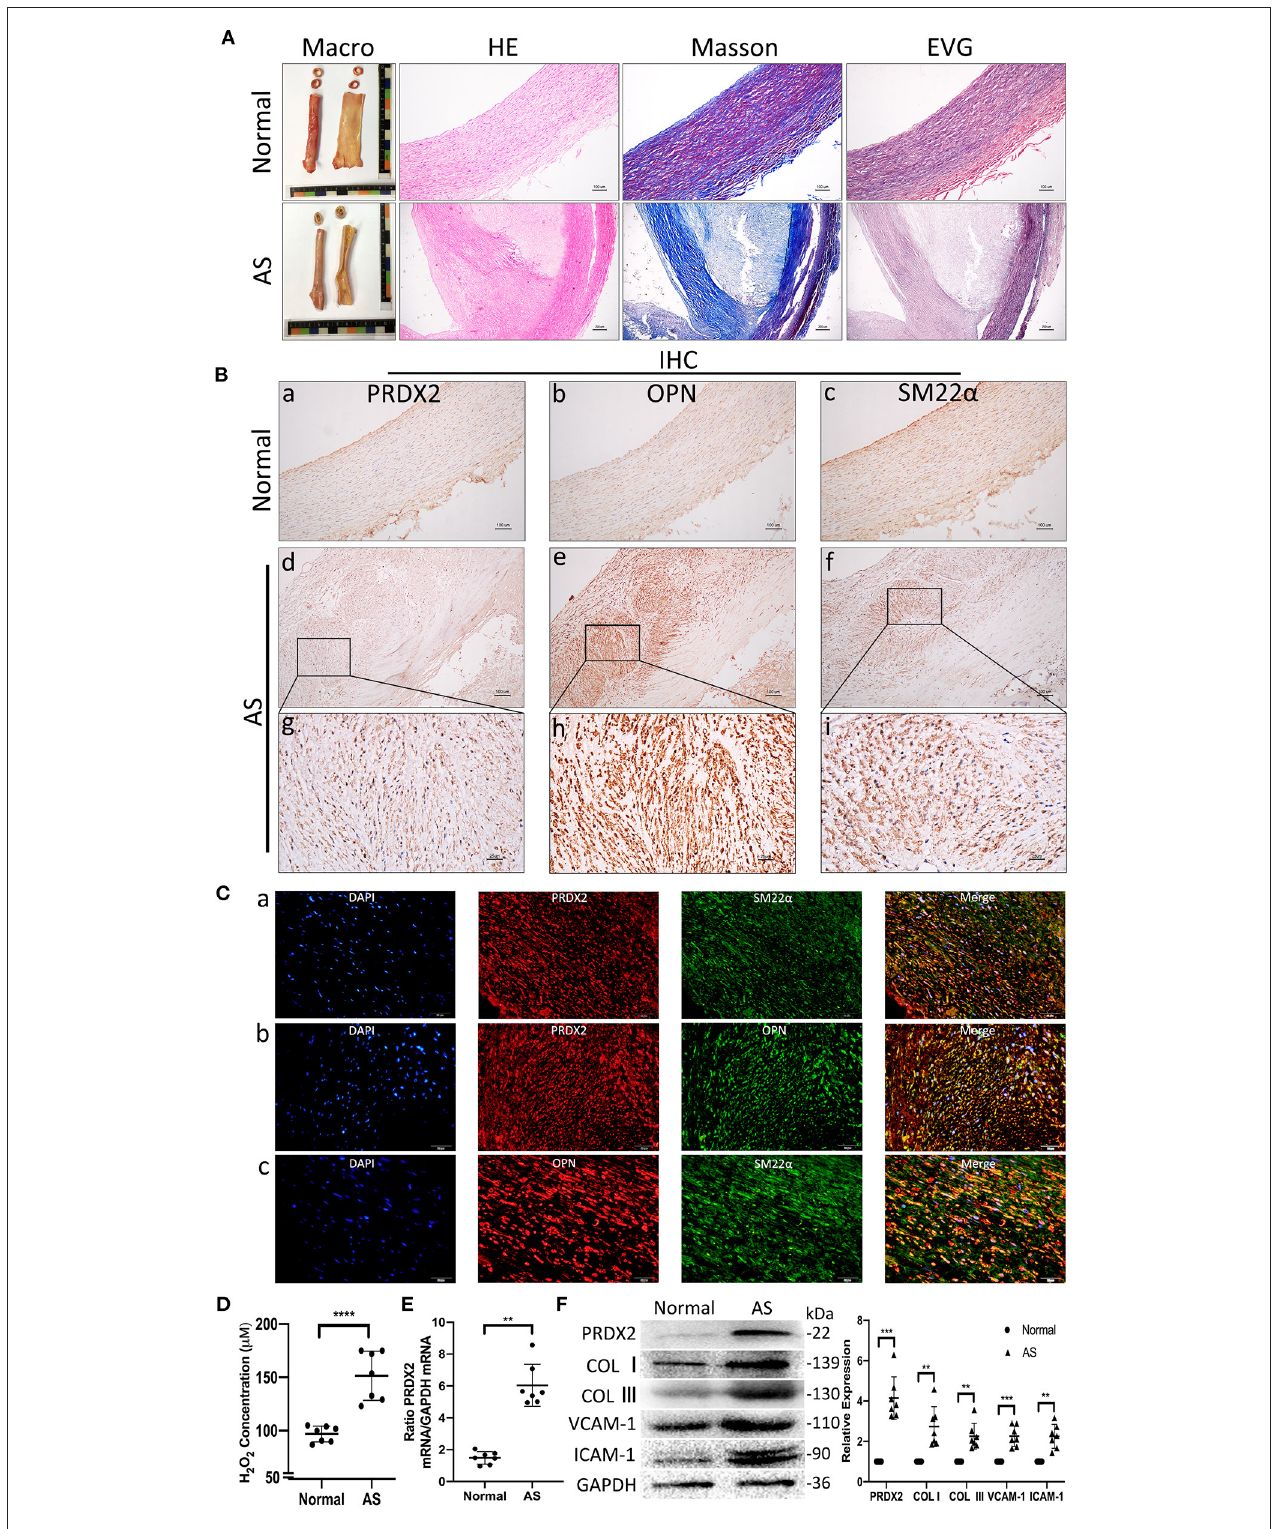
FIGURE 1 | Human carotid artery samples have higher PRDX2 than normal artery samples and alteration of the VSMC in AS. (A) Human carotid artery tissue samples. Representative images of H&E, EVG, and Masson’s trichrome staining. In Masson’s trichrome staining, collagen fibers were stained blue, and